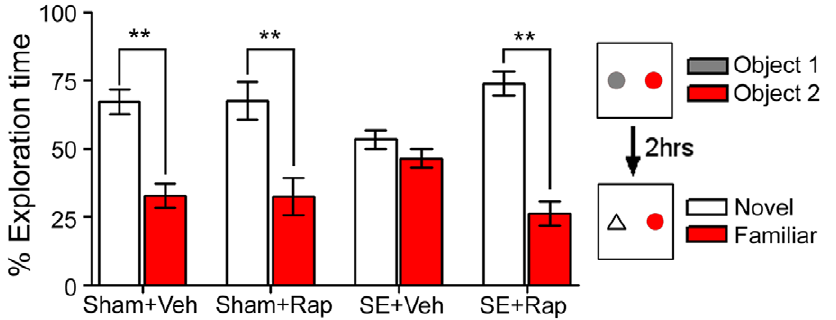
Figure 2. Rapamycin improved recognition memory in rats subjected to SE. The novel object recognition test was used to assess recognition memory in sham and SE rats treated with rapamycin (Rap) or vehicle (Veh). Rats were allowed to explore 2 objects for 5 minutes during the training phase. Two hours later, the rats were re-exposed to a previously explored object (familiar object) and a novel object, and exploration time of each object was evaluated. Sham + Veh and Sham + Rap rats spent significantly more time exploring the novel object than the familiar object. SE + Veh rats spent a similar amount of time exploring both objects. This deficit was reversed by rapamycin in the SE + Rap group. ** P , 0.001, ANOVA with Tukey’s post hoc test; n=7 2 11. Error